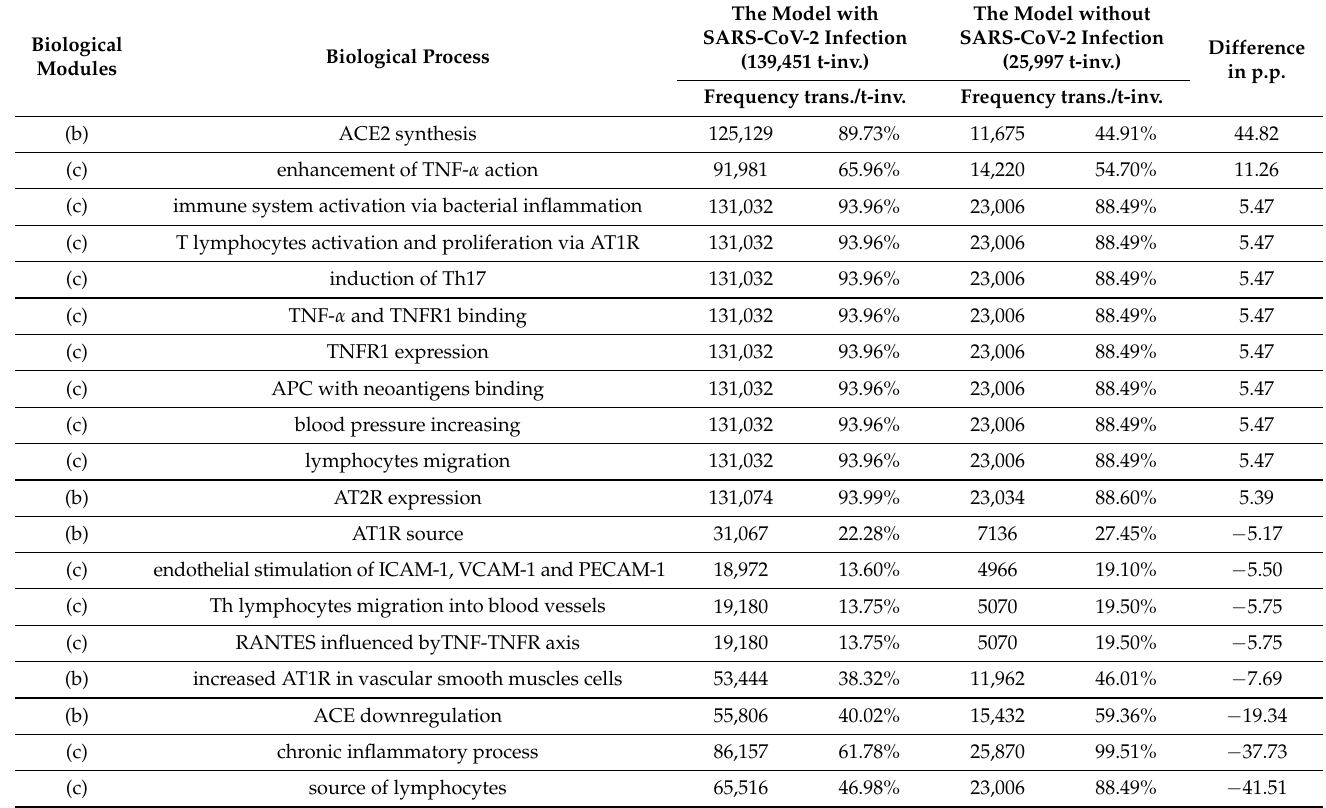
Table 5. Summary of the most important differences obtained during the comparative analysis (139,451 t-inv. vs. 25,997 t-inv.)